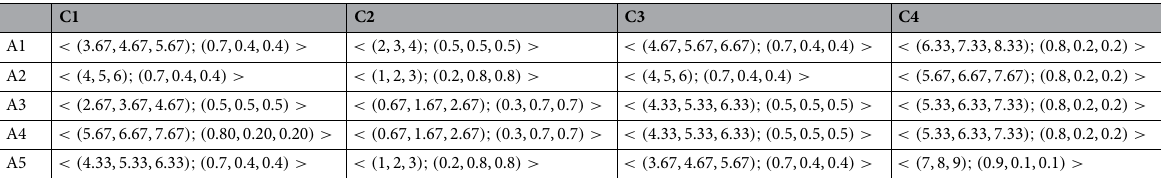
Table 6. The aggregated values of alternatives.